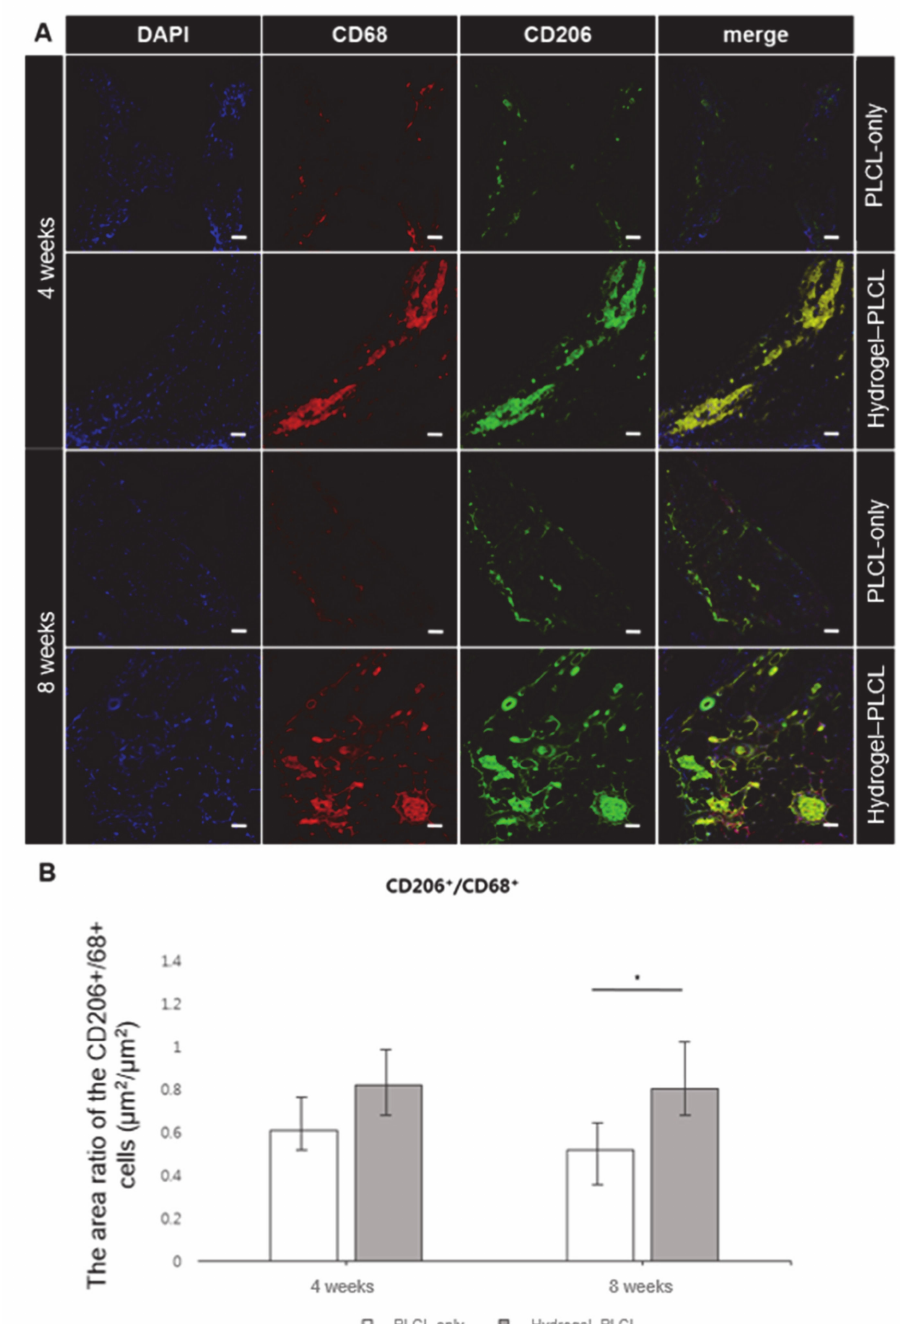
Figure 10. ( A ) Immunofluorescence images stained with CD68 and CD206 for investigation of macrophage infiltration. The images were obtained by confocal microscopy after 4 and 8 weeks in vivo (* p < 0.01). Scale bar = 50 µ m. ( B ) Quantitative analysis of the macrophage infiltration area for identification of the M1 and M2